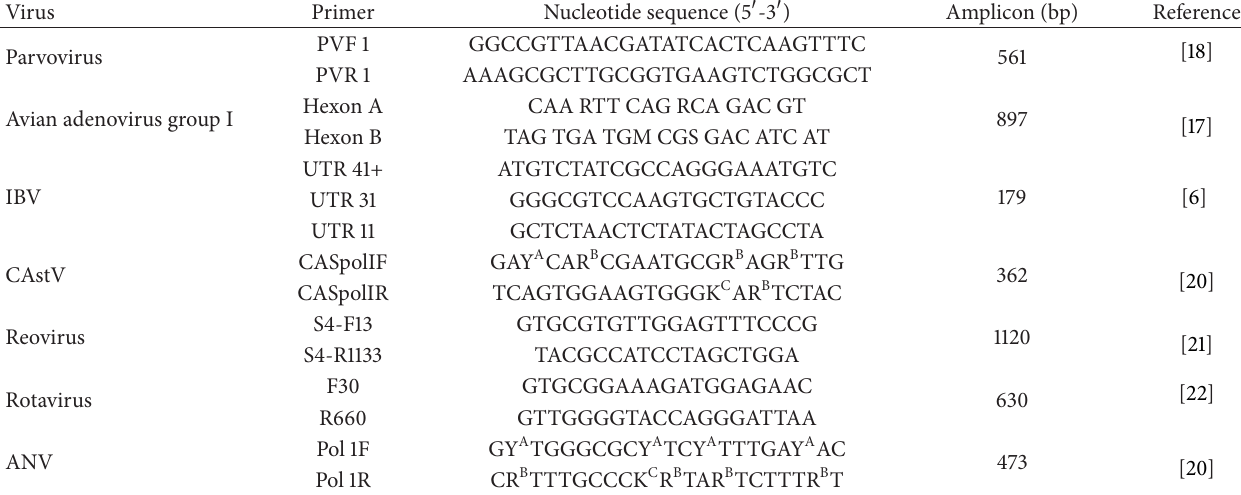
Table 1: Primers sets, nucleotide sequences, amplicons, and the corresponding references that were used to screen for the viruses.